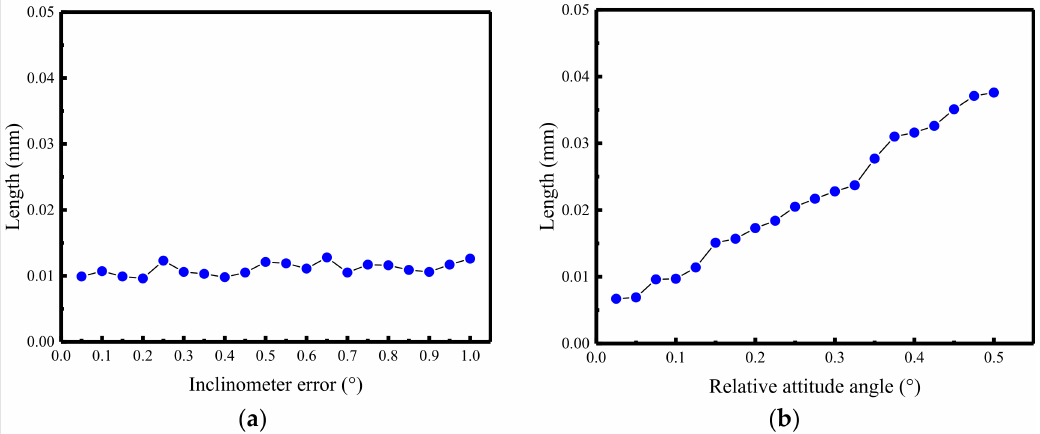
Figure 6. Influence of angle input error: ( a ) inclinometer error; ( b ) attitude